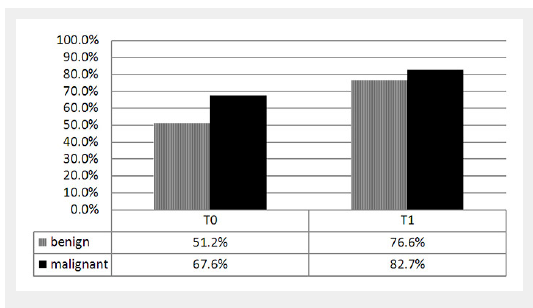
Figure 2 Percentage of correctly classified skin lesions before (T0) and after (T1) the one-day dermatologic education